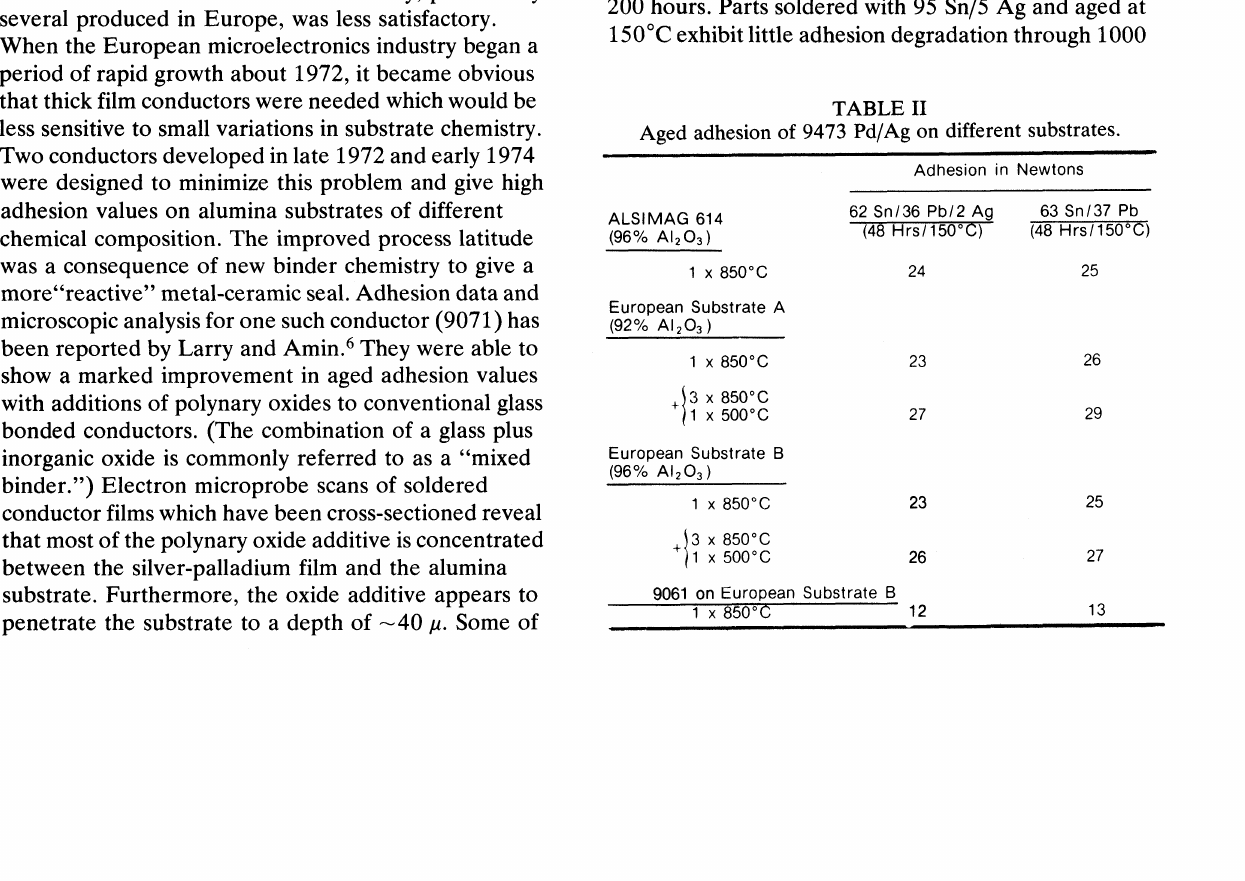
Aged adhesion of 9473 Pd/Ag on different